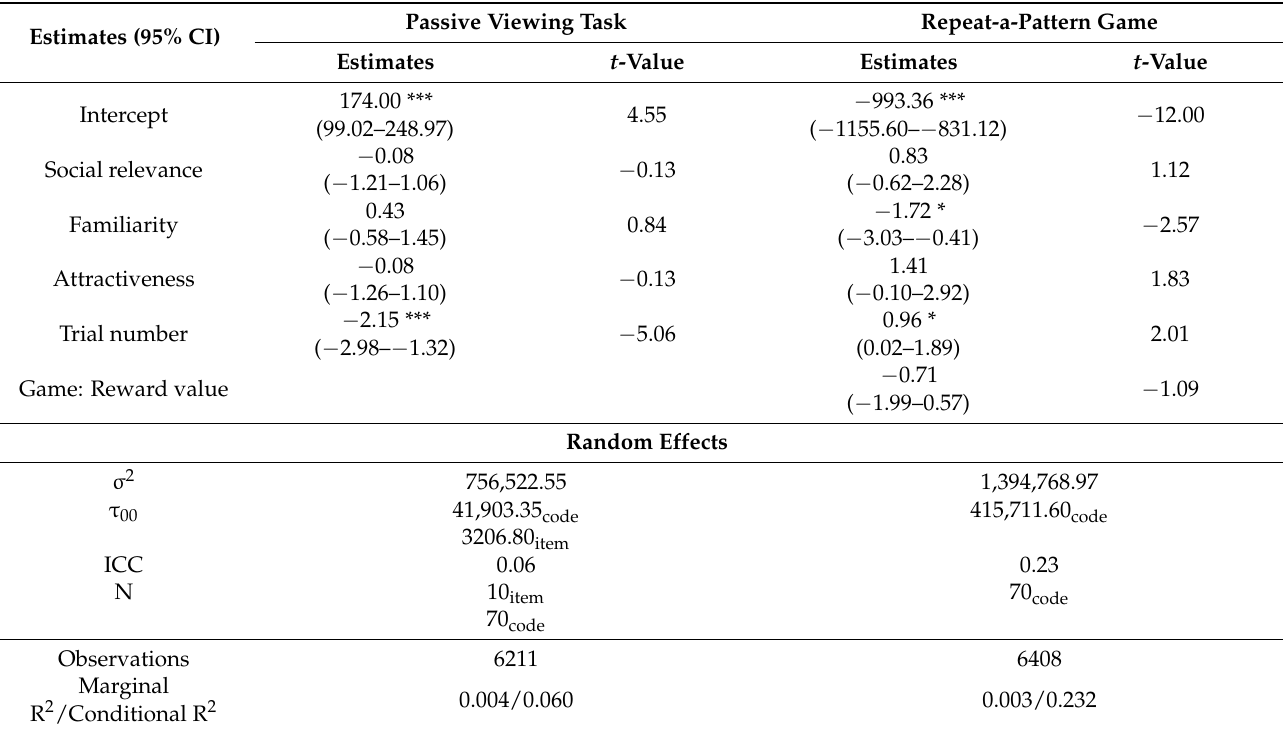
Table 2. Mixed effects models investigating the effects of social relevance, familiarity, and reward value on pupil size in the repeat-a-pattern game and in the passive viewing task (with attractiveness and trial number as